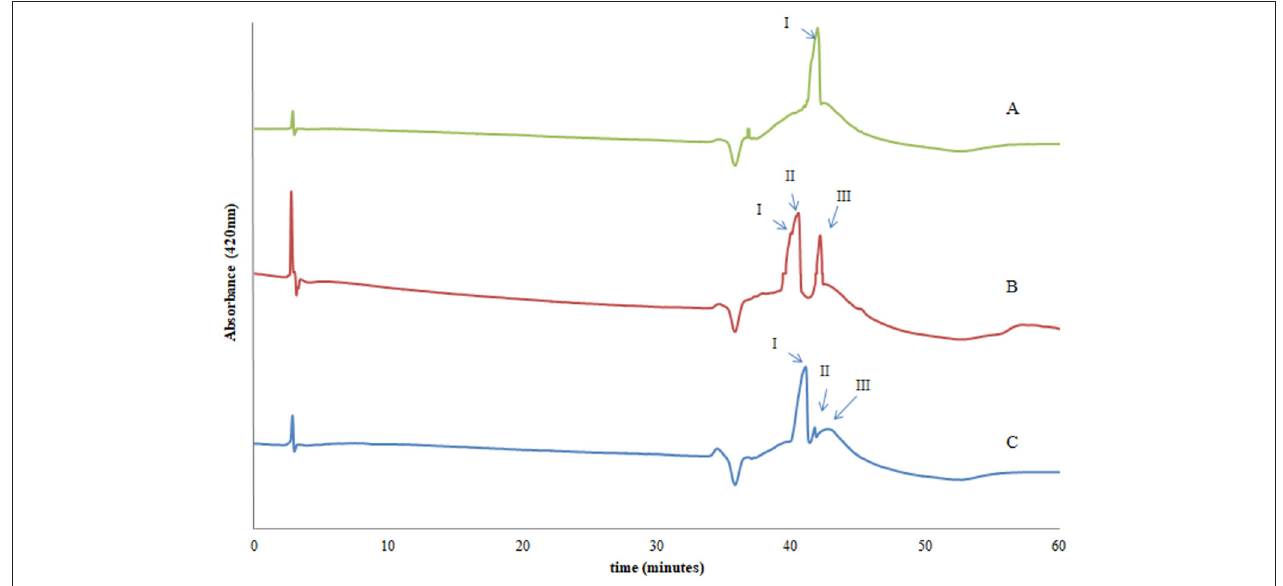
FIGURE 9 | HPLC-DAD chromatograms at λ 420nm of melanoidins (nominal MW from 400 to 1,800 Da) from DL prepared at pH i of 6.5 (A) , 7.0 (B) , and 7.5 (C)